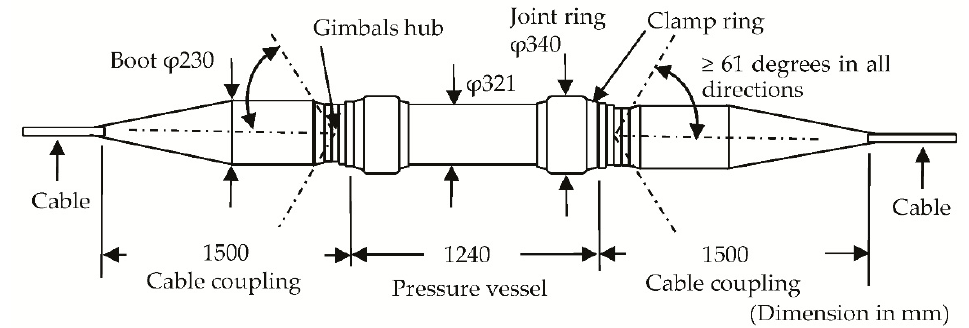
Figure 1. Schematic construction of OS-560M submarine optical repeater.